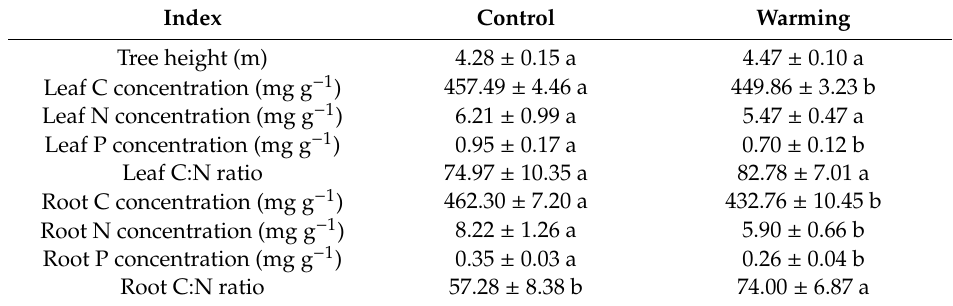
Table 2. The effects of warming on tree height and concentrations of leaf and root C, N, and P in Cunninghamia lanceolata .